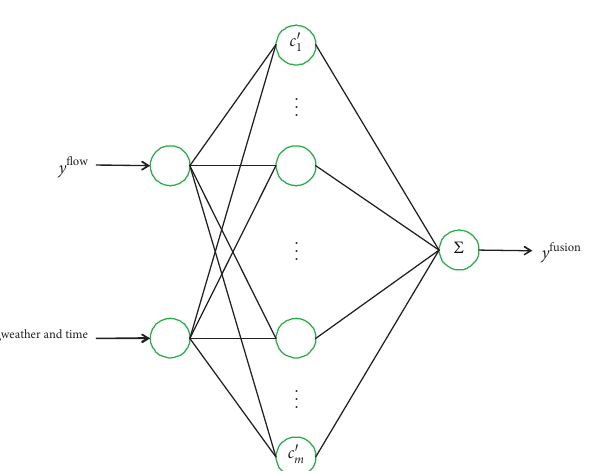
Figure 7: The structure of RBF in